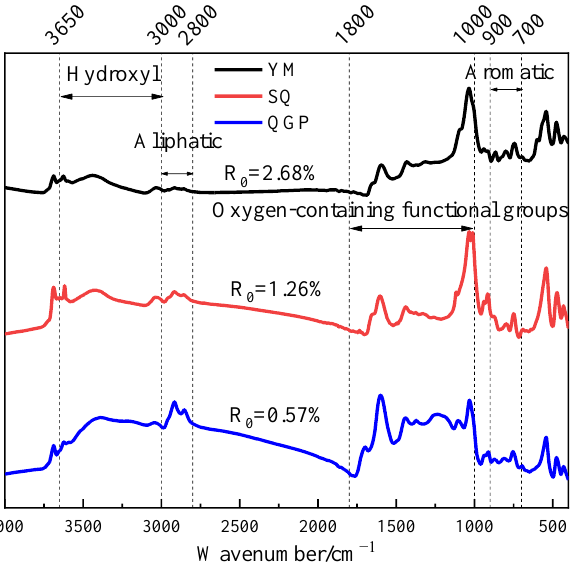
Figure 6. FTIR spectrum of coal